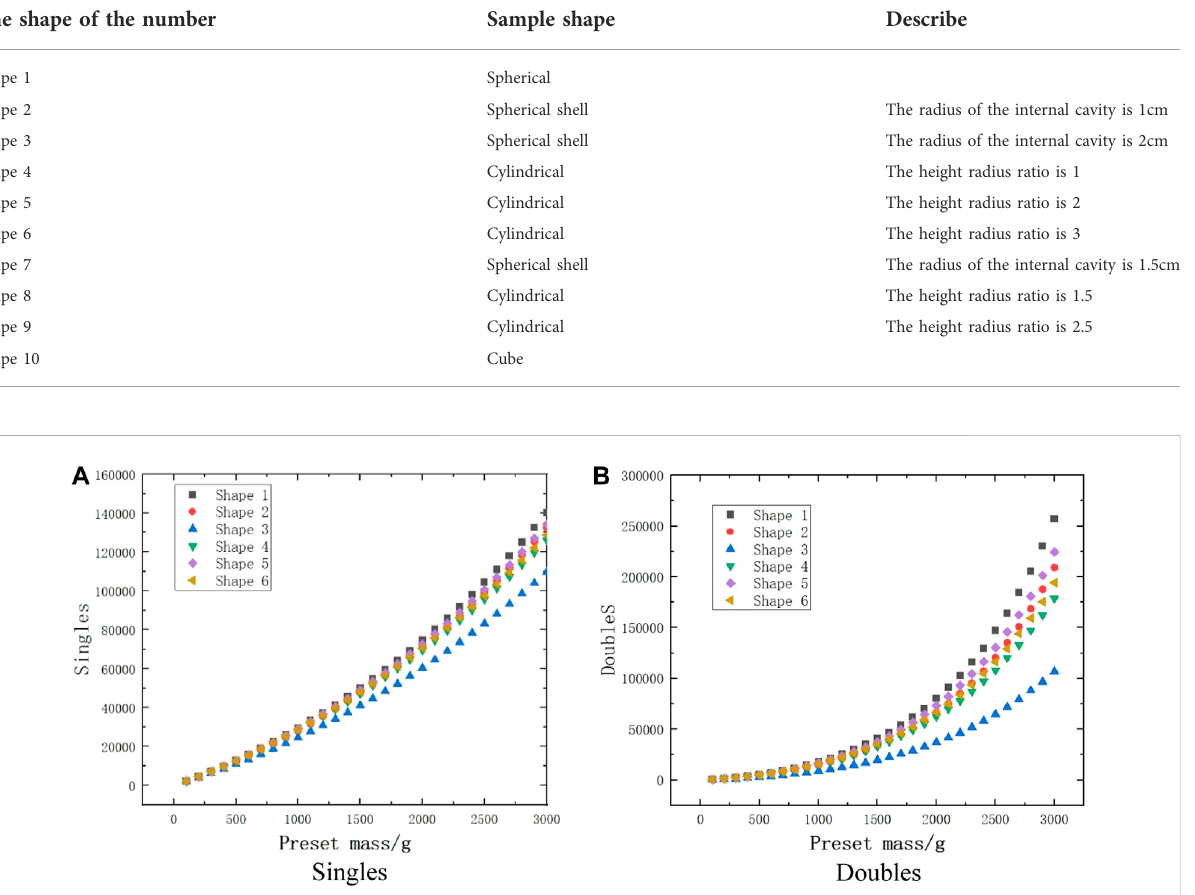
TABLE 1 Sample parameters of shape 1 – 10.